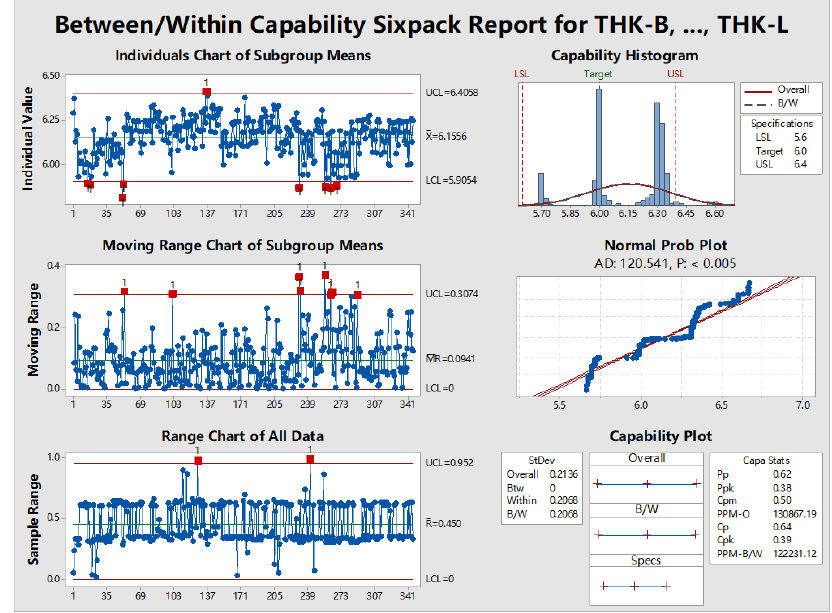
Figure 6. Thickness between/within capability sixpack report for the 345 wafers.